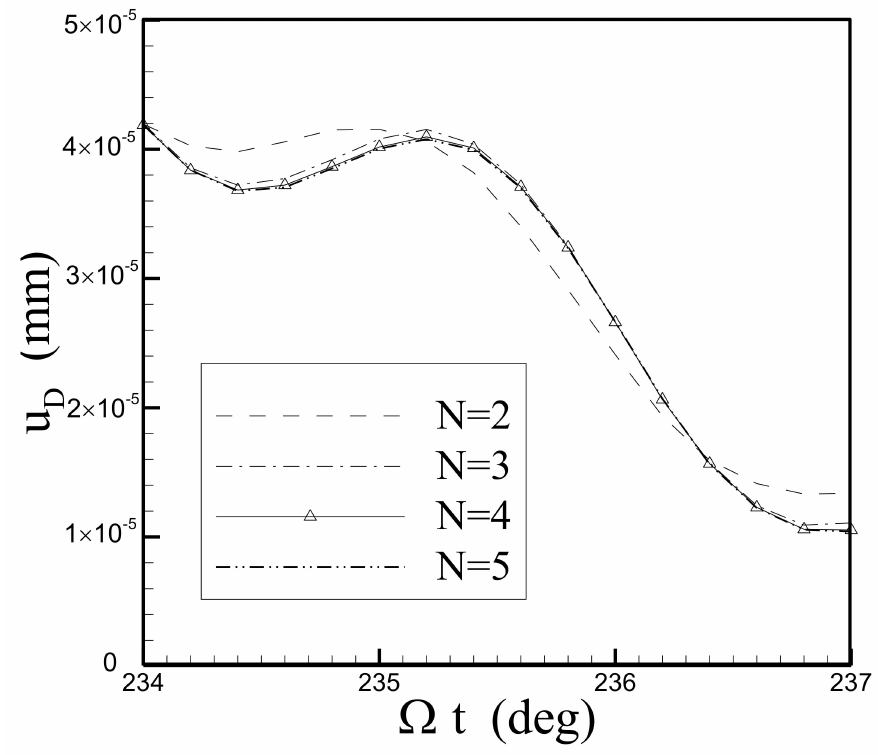
Figure 5. The time responses of the follower output node D in the axial direction where Ω = 320 rad/s, using four mode